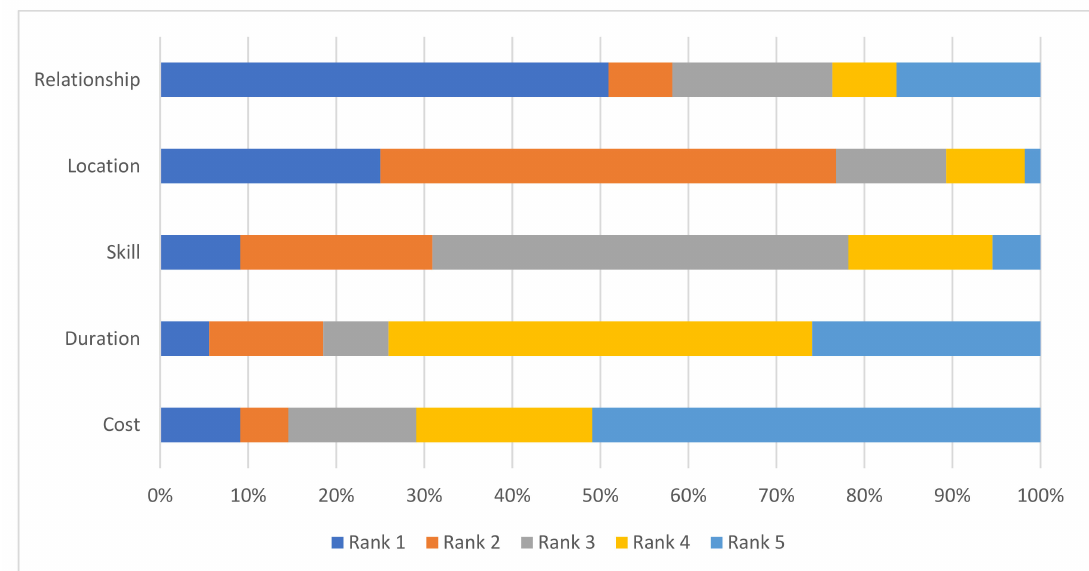
Figure 2. Owner’s ranking of the reason that they selected a particular farrier to provide services to their donkey. Relationship—the relationship between the owner and the farrier; Location—the location of the farrier; Skill—the skill or knowledge of the farrier; Duration—the time between shoeings; Cost—the charge per hoof.